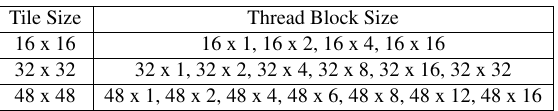
Table 2: Experimental